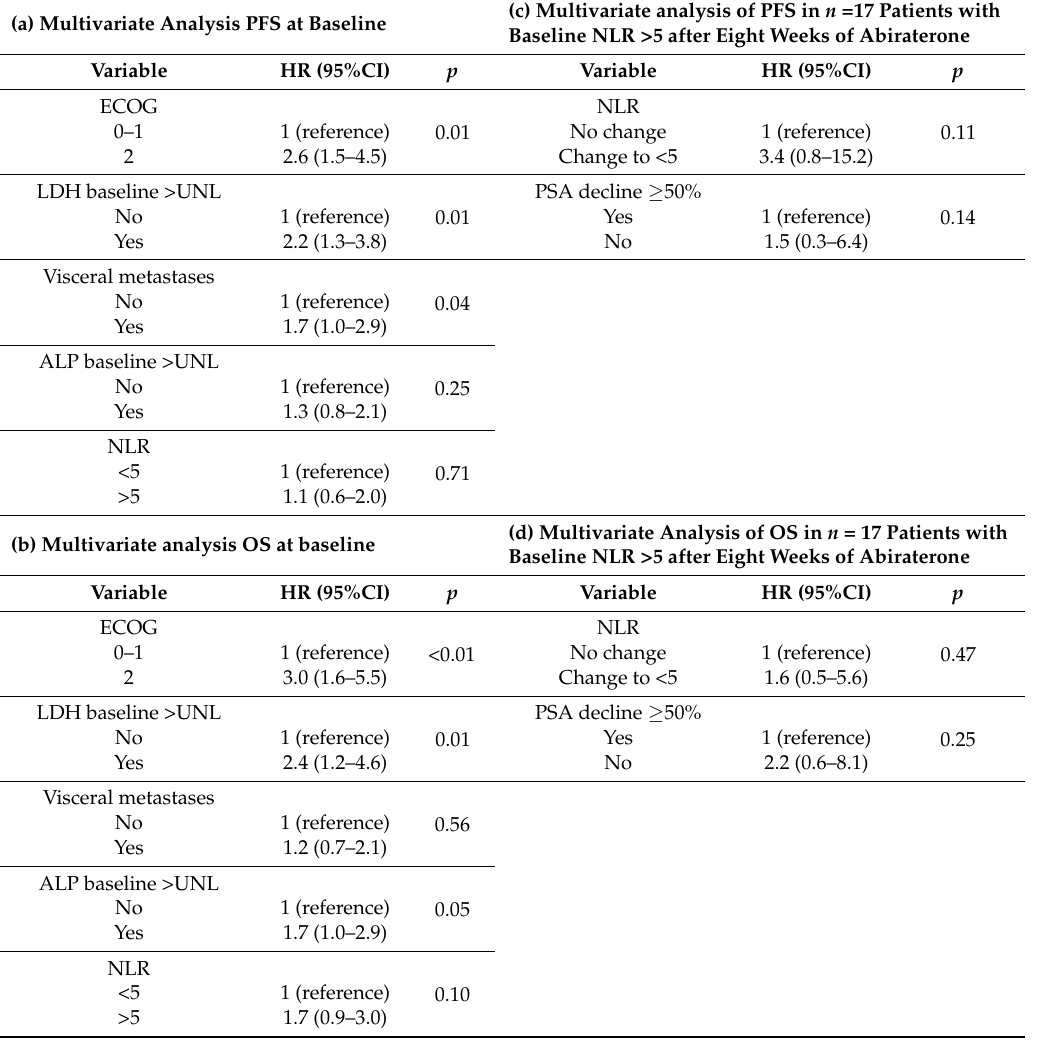
Table 4. Multivariate analysis for significant baseline biomarkers for (a) progression-free and (b) overall survival in 96 mCRPC-patients prior to Abiraterone therapy and (c) progression-free survival and (d) overall survival in 17 patients with a baseline NLR >5 after eight weeks of